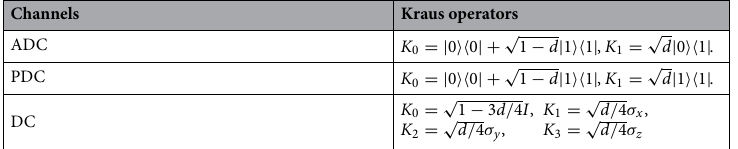
0, 1 represents the ∈ [ ]